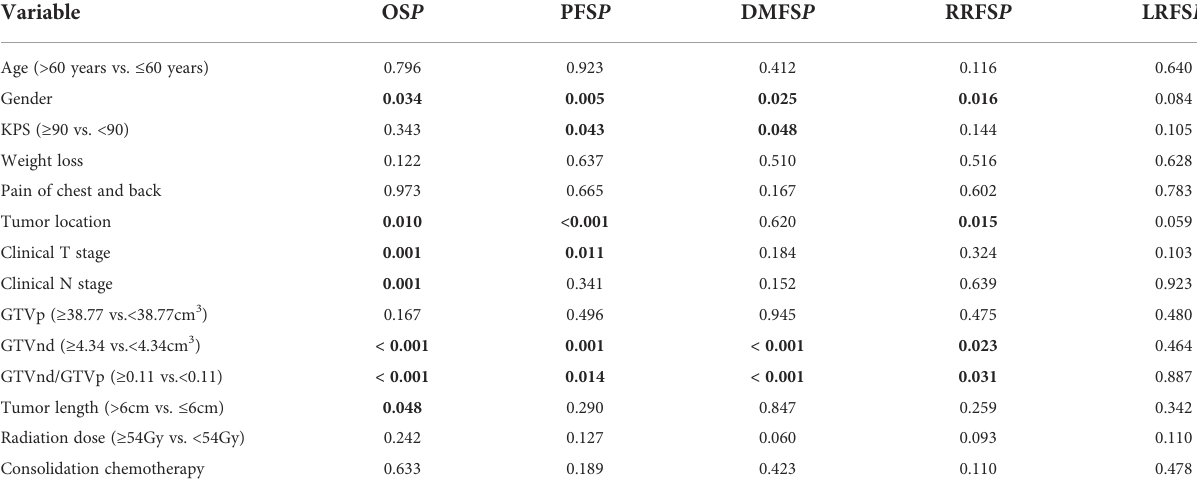
TABLE 2 Univariate cox proportional hazard regression analysis of prognostic factors in patients with ESCC (n=252). Variable